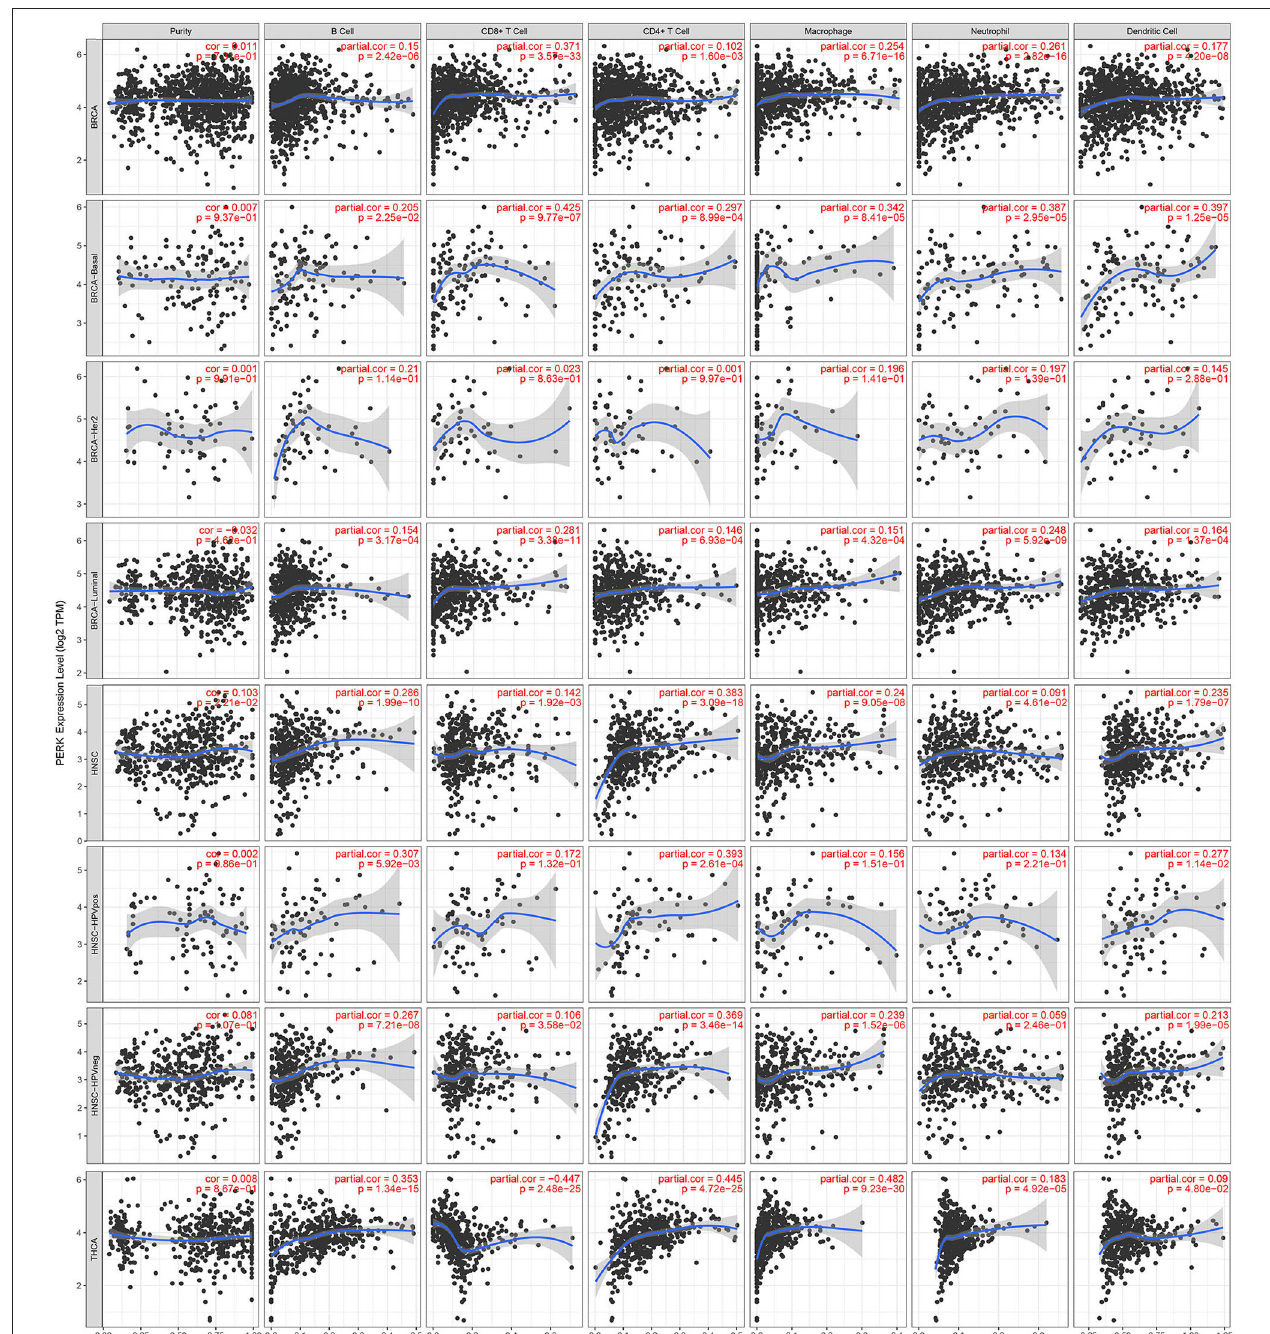
FIGURE 7 | Correlations of PERK expression with immune infiltration level in BRCA, BRCA-basal, BRCA-Her2, BRCA-luminal, HNSC, HNSC-HPV positive, HNSC-HPV negative, and THCA.